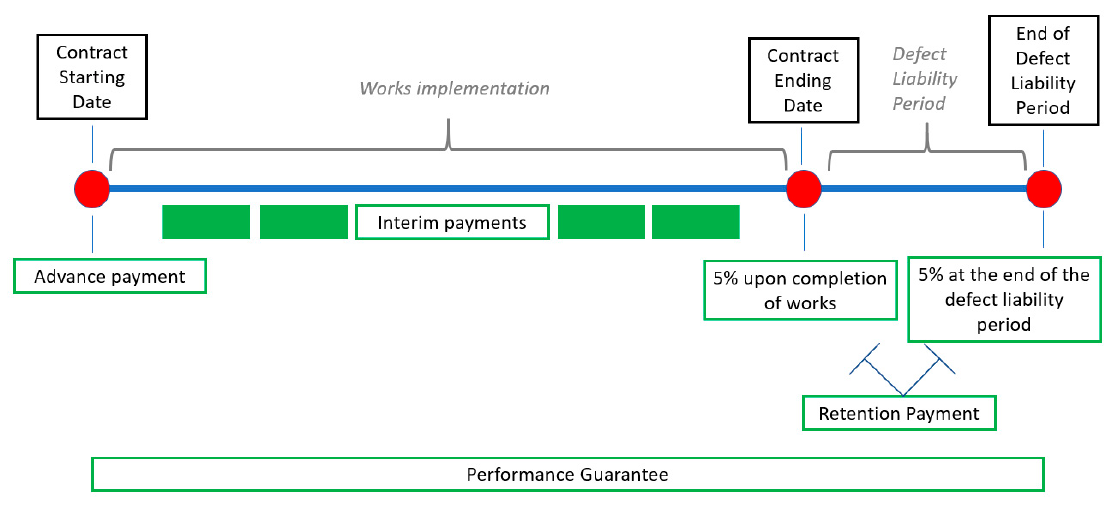
Figure 1. B-CB-T Figure 1. B-CB-T schematic.